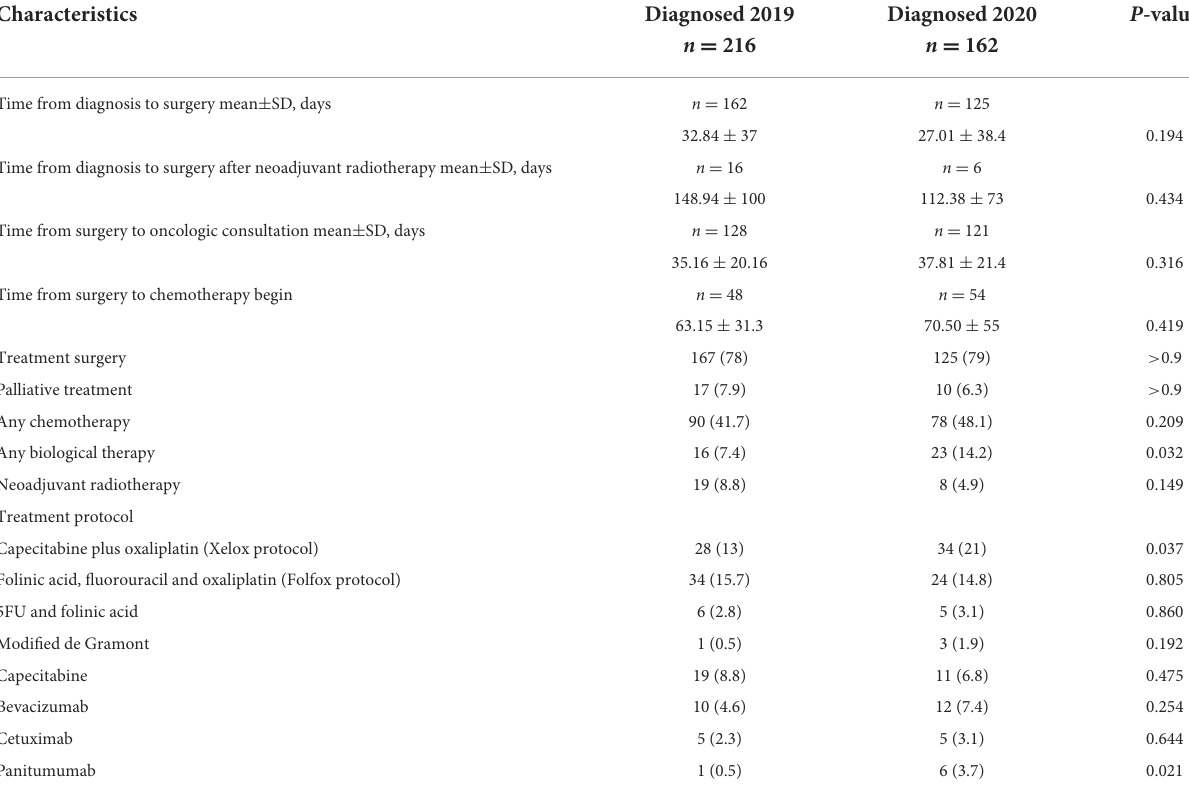
TABLE 1B Timing and treatment of colorectal cancer